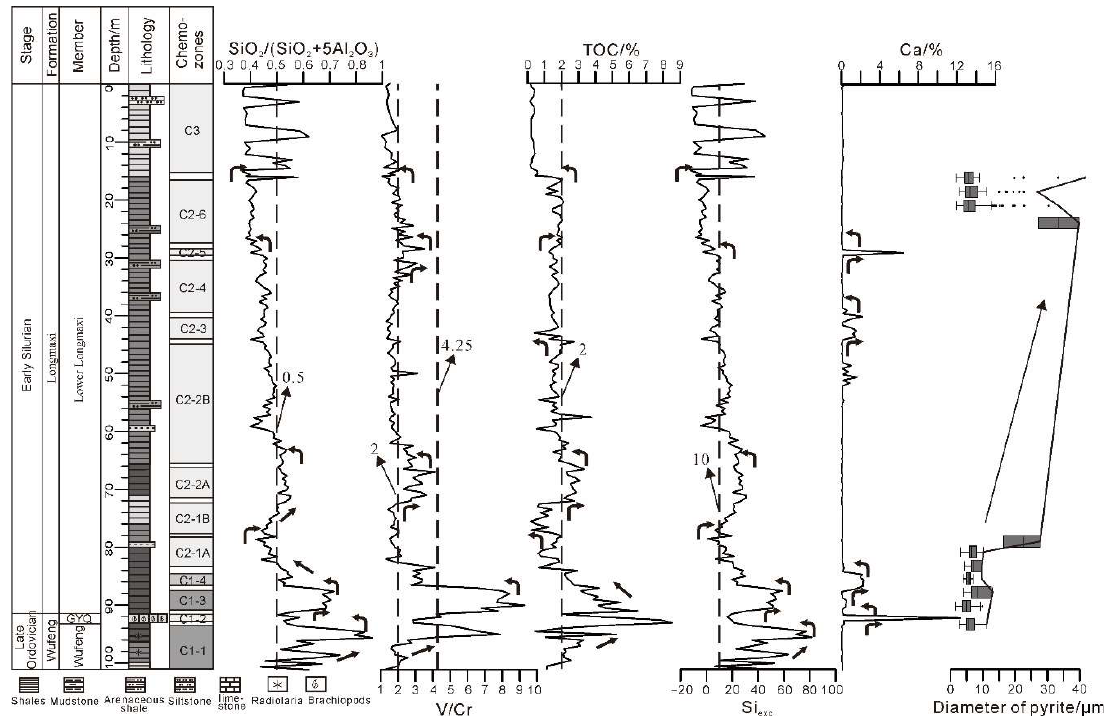
Figure 4. The chemostratigraphic scheme of the Wufeng and the Lower Longmaxi Fm., and profiles of geochemical proxies, as well as the statistics of framboid